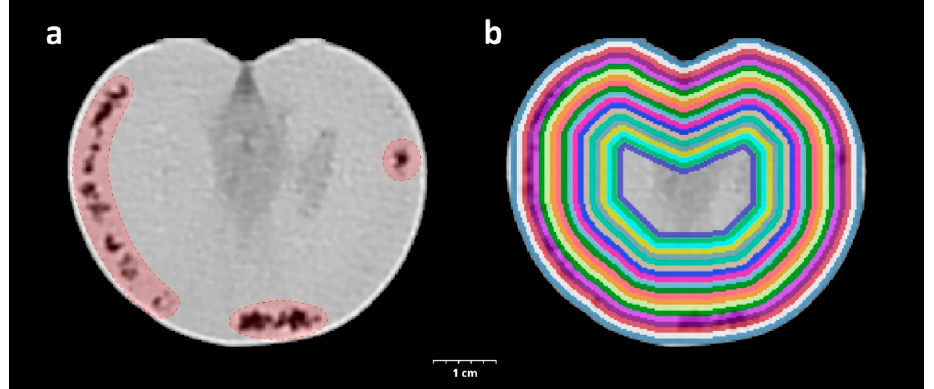
Figure 1. CT-assisted visualization of the triggered inner structure changing of experimental tomato damaged by H. halys . The tissue destruction caused by the injected salivary is highlighted in red ( a ). Visualization of the 20 concentric, approximately 1 mm thick binary masks created for sampling shells from the CT scan of a tomato ( b ).